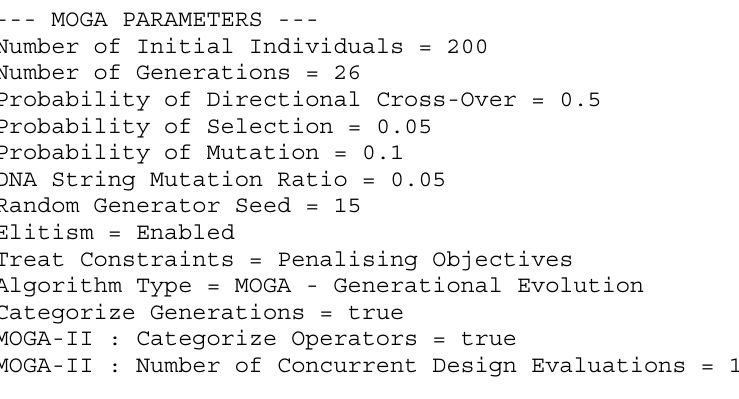
Figure 26. Optimization parameters.